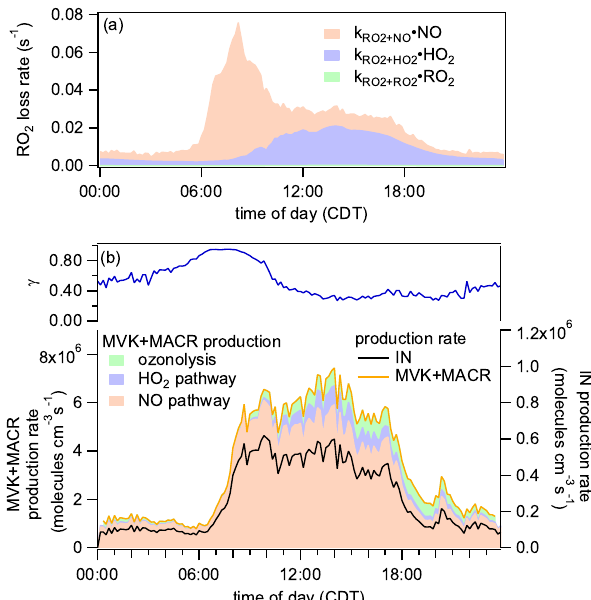
Figure 7. (a) Diurnal average of RO 2 loss rates for reaction with NO, HO 2 , and RO 2 from 22 June to 7 July. (b) Diurnal average of γ value and production rates of IN and MVK + MACR from 22 June to 7 July. For MVK + MACR, production from the three reaction channels are shown in different